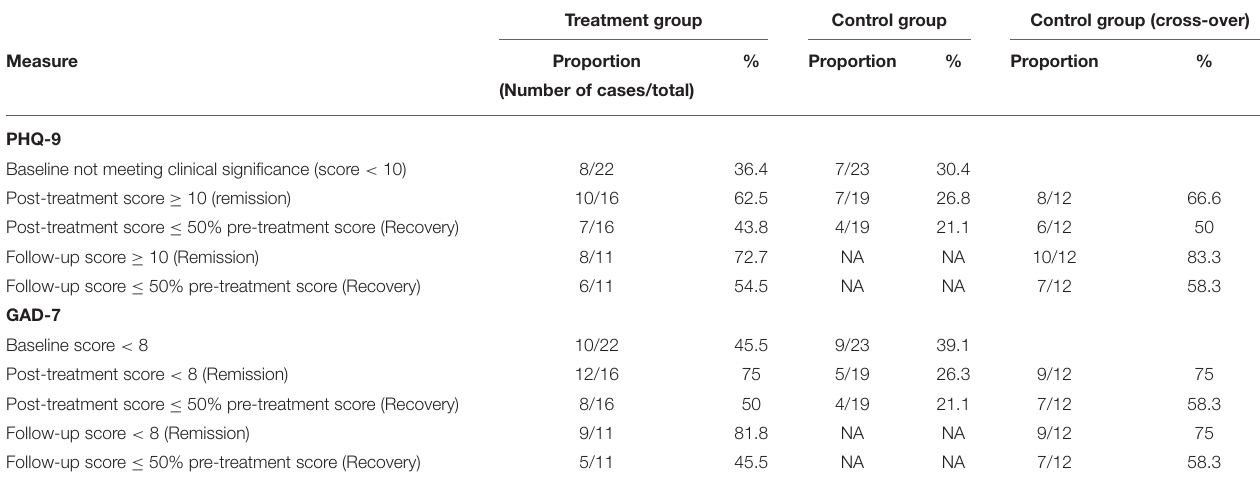
TABLE 3 | Proportion of participants above and below cut-off scores of clinical significance (remission) and proportion demonstrating at least 50% reduction in pre-treatment scores (recovery). Treatment group Control